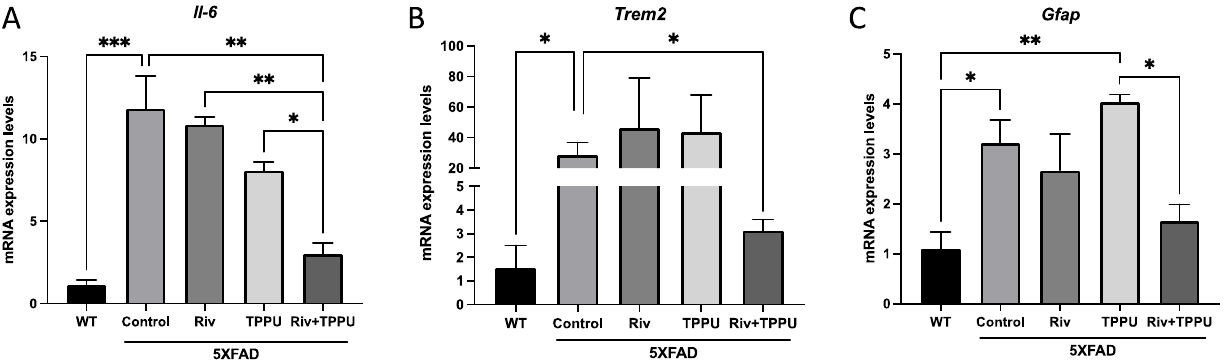
Figure 6. Gene expression of ( A ) Il-6 , ( B ) Trem2 and ( C ) and Gfap . Results are expressed as a mean ± SEM. WT, n = 4; 5XFAD control, n = 3; 5XFAD treated with TPPU (1 mg/kg/day), n = 3; 5XFAD treated with Riv (1 mg/kg/day), n = 3; 5XFAD subjected to co-treatment with TPPU (1 mg/kg/day) plus Riv (1 mg/kg/day), n = 4. Groups were compared by the one-way ANOVA test and post-hoc Tukey test. * p < 0.05; ** p < 0.01; *** p < 0.001. Abbreviations: Riv = rivastigmine; Il-6 = interleukin-6; Trem2 = triggering receptor expressed on myeloid cell 2; Gfap = glial fibrillary acidic protein.